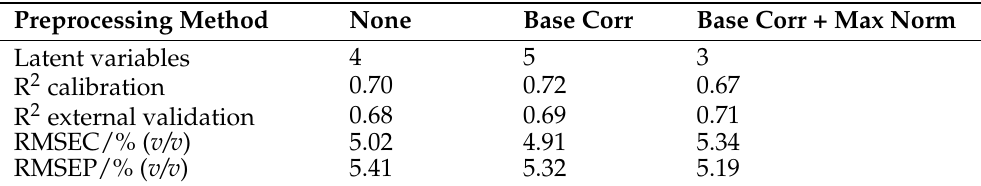
Figure 5. nirU data PCA based on baseline correction, conducted on the whole spectra, of pure diesel (DP) and diesel with varying concentrations of biodiesel. A PLS models built to quantify the biodiesel concentration in the DPB blend (Table 7) based on data preprocessed with baseline correction and maximum normalization showed a validation R-squared value of 0.71 and a 5.19% ( v / v ) RMSEP. Table 7. PLS models based on nirU data, with diverse preprocessing methods to determine biodiesel content in the DPB blend (0 to 15% ( v / v